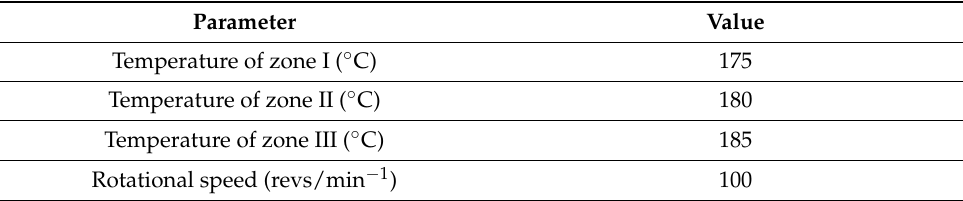
Table 1. Parameters of composite